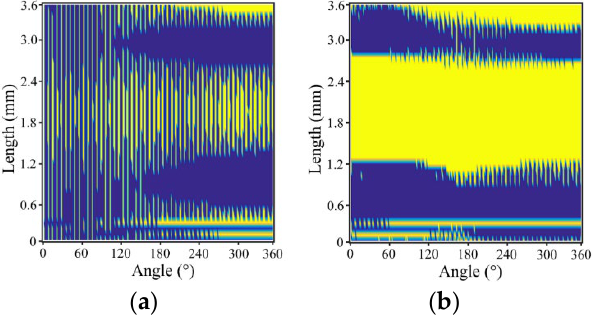
Figure 16. Inner side surface contact state of C-ring under different working distances. ( a ) 0 km; ( b ) 14.4 km.